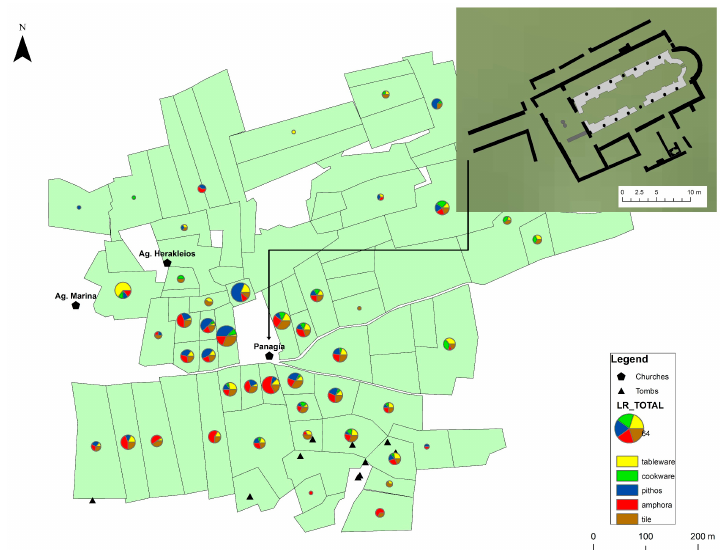
Figure 7. Late Antique surface ceramic concentration (by pottery types) around the Early Christian basilica of Panagia in the region of Kofinou, with the architectural plan of the church. Image© SeSaLaC.